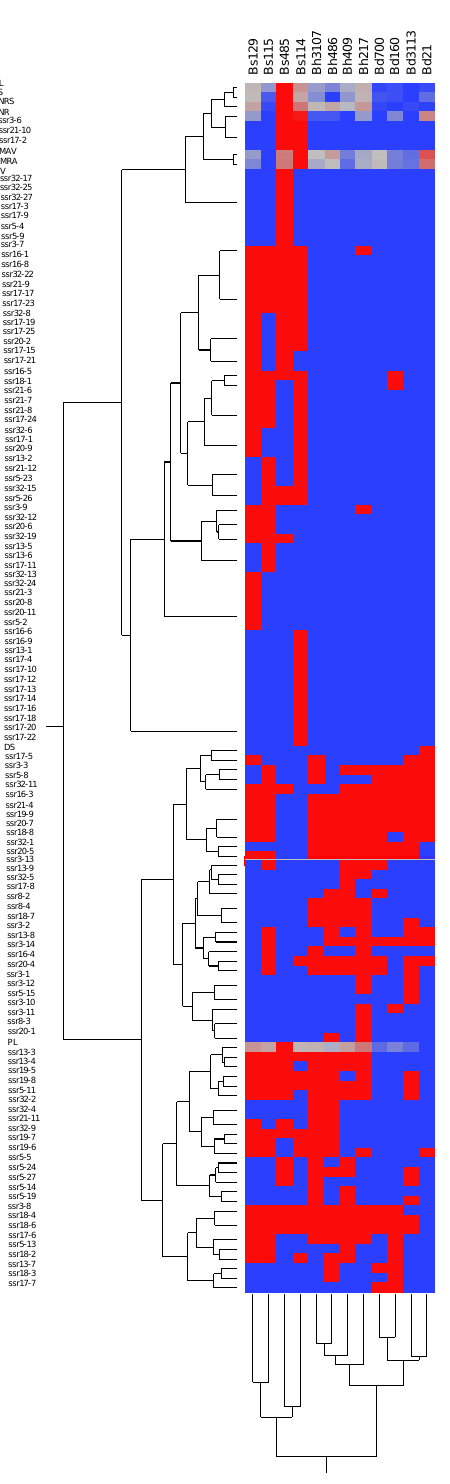
Figure 3. Two-way hierarchical clustering of the Brachypodium ssp. genotypes by JMP cluster analysis of distance similarities bases on RSA variables and SSR markers (ssr-). DS: mean diameter of the seminal roots, L: total root length, MAV: the minimum seminal root angle with respect to the vertical, MRA: mean of all seminal root angles with respect to the vertical, NR: number of seminal roots, NRS: number of secondary roots, PL: primary root length, S: total surface area of the roots, V: total root volume.